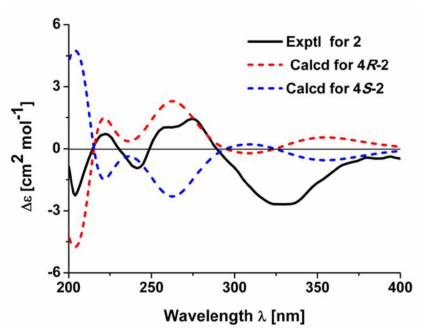
Figure 4. Experimental electronic circular dichroism (ECD) spectrum of 2 and calculated ECD spectra of 4 R - 2 and 4 S - 2